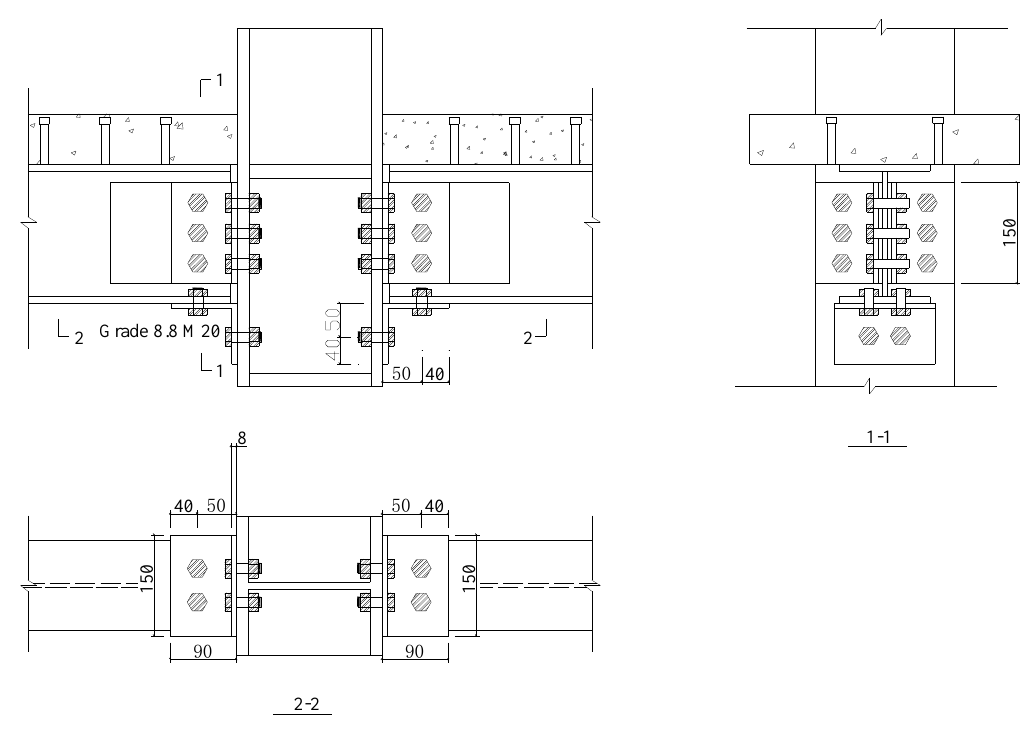
Figure 13. Retrofit strategy 1 (unit: mm).